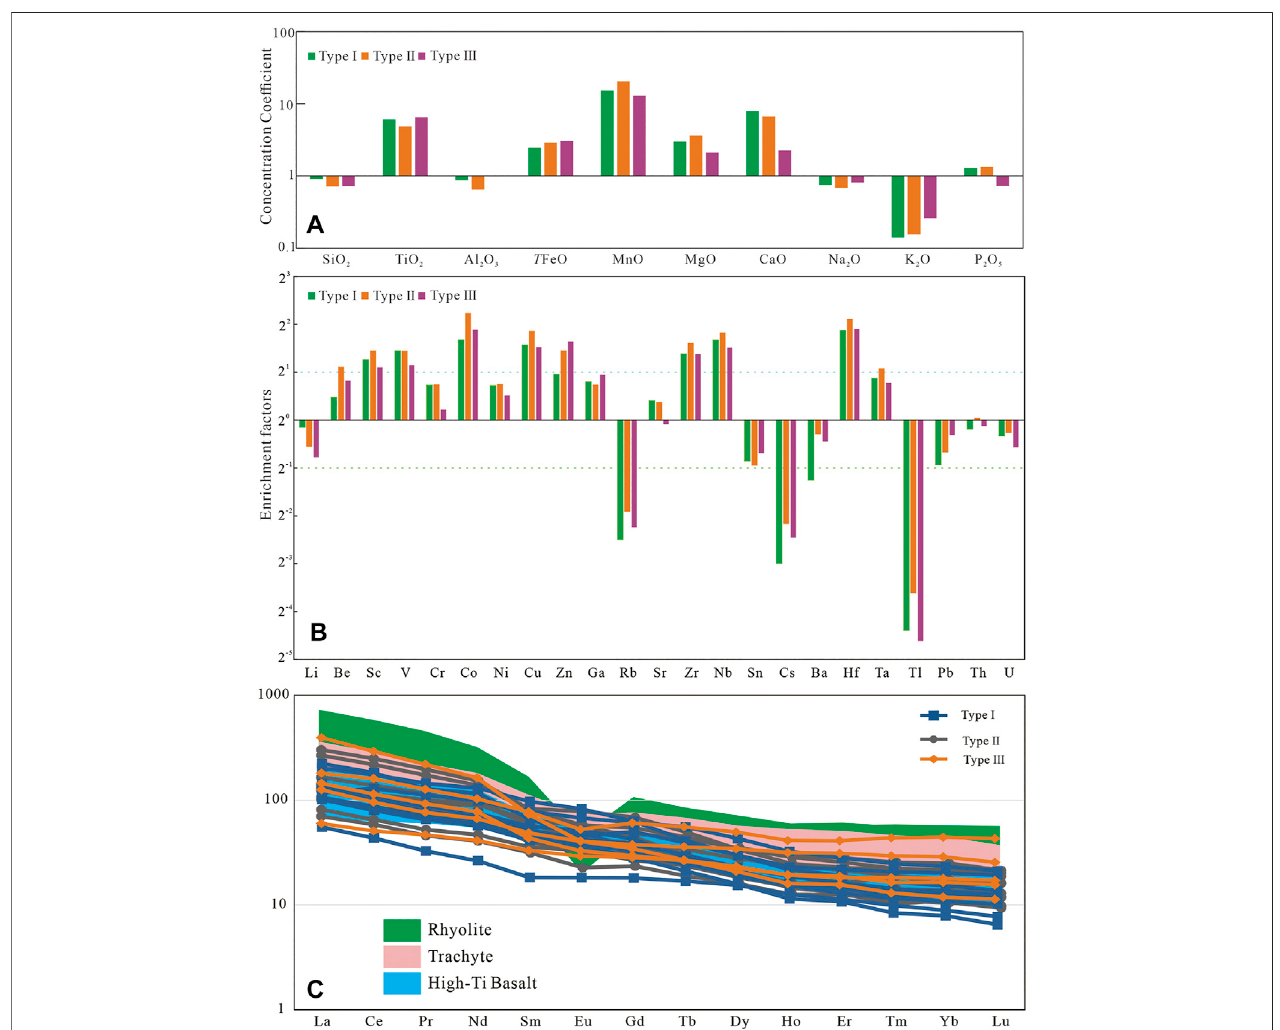
FIGURE 3 | (A) Major elements concentration coef fi cients (CC) of the studied samples, normalized by the UC. (B) Enrichment factors of trace elements ofdifferent types of siderite; (C) REE distribution pattern of different types of siderite. The pink and green areas are for trachyte and rhyolite (Xu et al., 2010), and the blue area is for high-Ti basalt (Xiao et al.,